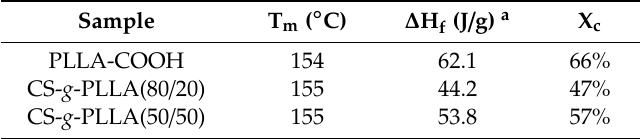
Figure 3. ( a ) Di ff erential scanning calorimetry (DSC) thermographs (first heating cycle) and ( b ) thermogravimetric analysis (TGA) curves for CS (black line), PLLA-COOH (red line), CS- g -PLLA(80 / 20) (blue line) and CS- g -PLLA(50 / 50) (green line). Table 1. Thermal properties of the CS- g -PLLA